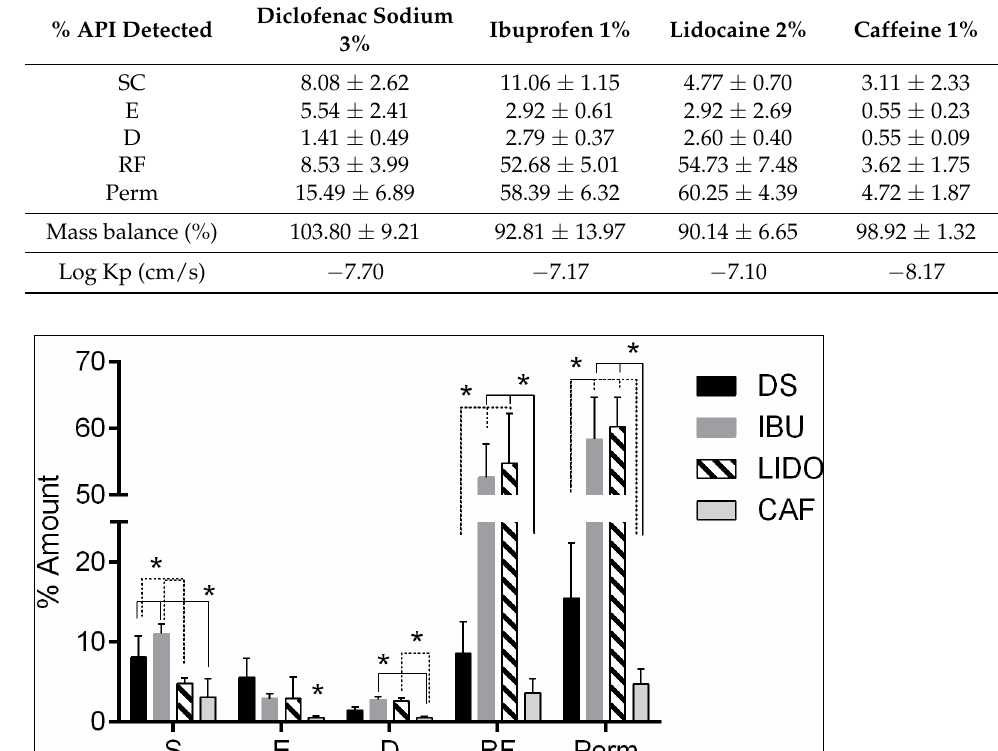
Table 4. Normalized amounts of active ingredients (% API) found in the stratum corneum (SC), epidermis (E), dermis (D), receptor fluid (RF), total permeation (Perm), and log Kp.